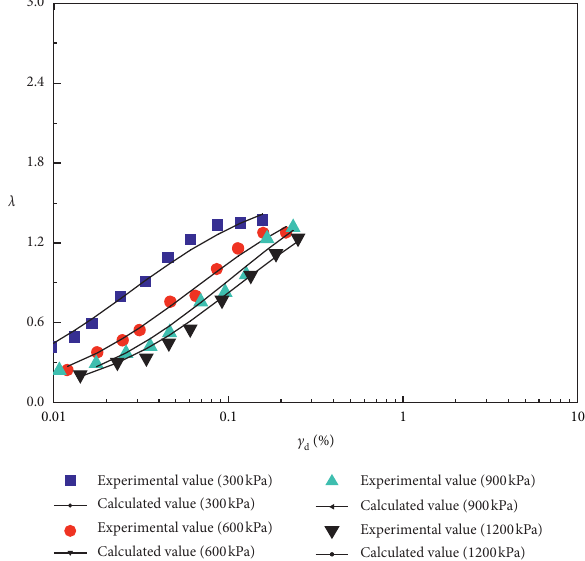
Figure 15: Experimental damping ratio results and their corre- sponding calculated